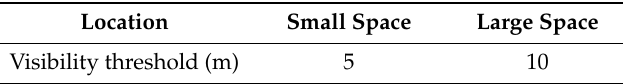
Table 3. Visibility threshold for large and small